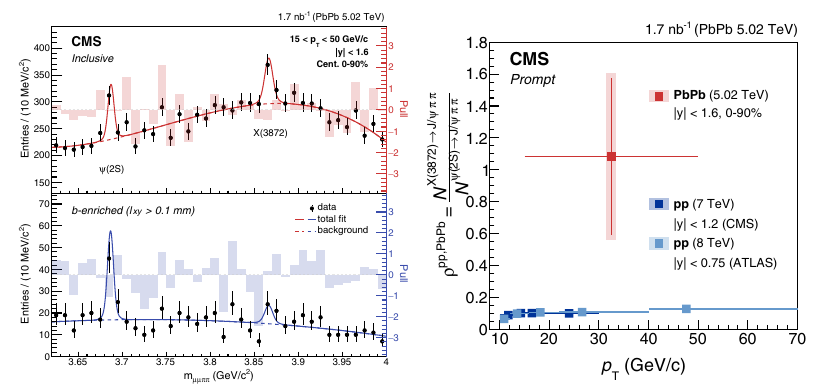
Figure 1. Left Panel: Invariant mass distribution of m µµππ in PbPb collisions, for the inclusive (upper) and B-enriched (bottom) samples. The vertical lines represent statistical uncertainties in the data. The pull distribution is represented by the shaded bars. Right Panel: ρ PbPb in PbPb collisions at √ s 5 . 02TeV. The vertical bars (boxes) correspond to statistical (systematic) uncertainties. ρ pp of prompt X(3872) over ψ (2 S ) production in pp collisions at √ s = 8TeV, measured by ATLAS [6], and at √ s = 7TeV, measured by CMS [5] are also